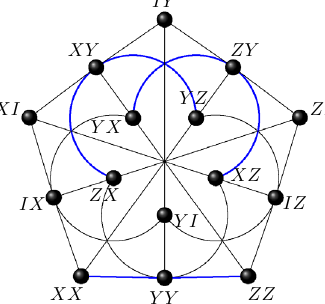
Figure 3. The symplectic polar space W ( 3, 2 ) labelled by two-qubit Pauli observables. Each line of the configuration forms a context. The three negative contexts are indicated in blue.